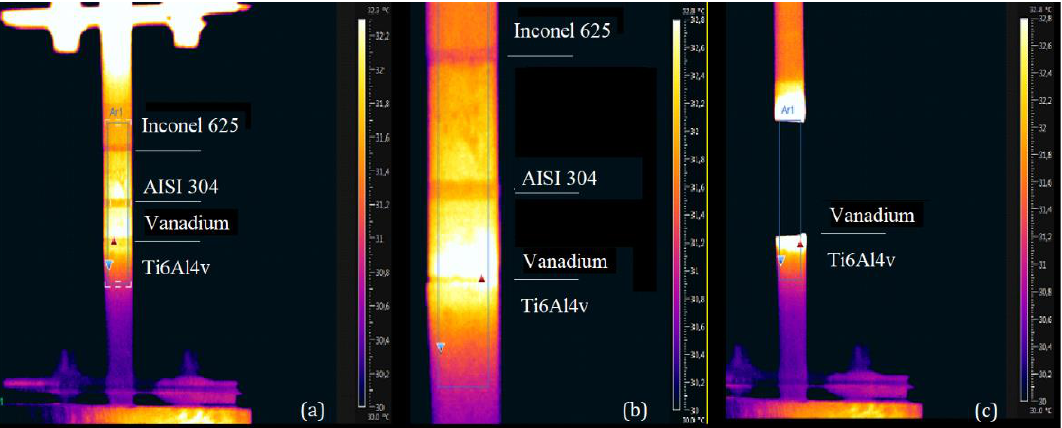
Figure 9. Temperature map during a fatigue test: ( a ) stabilized temperature at 30% of the fatigue life; ( b ) prior to fracture; ( c ) at fracture.